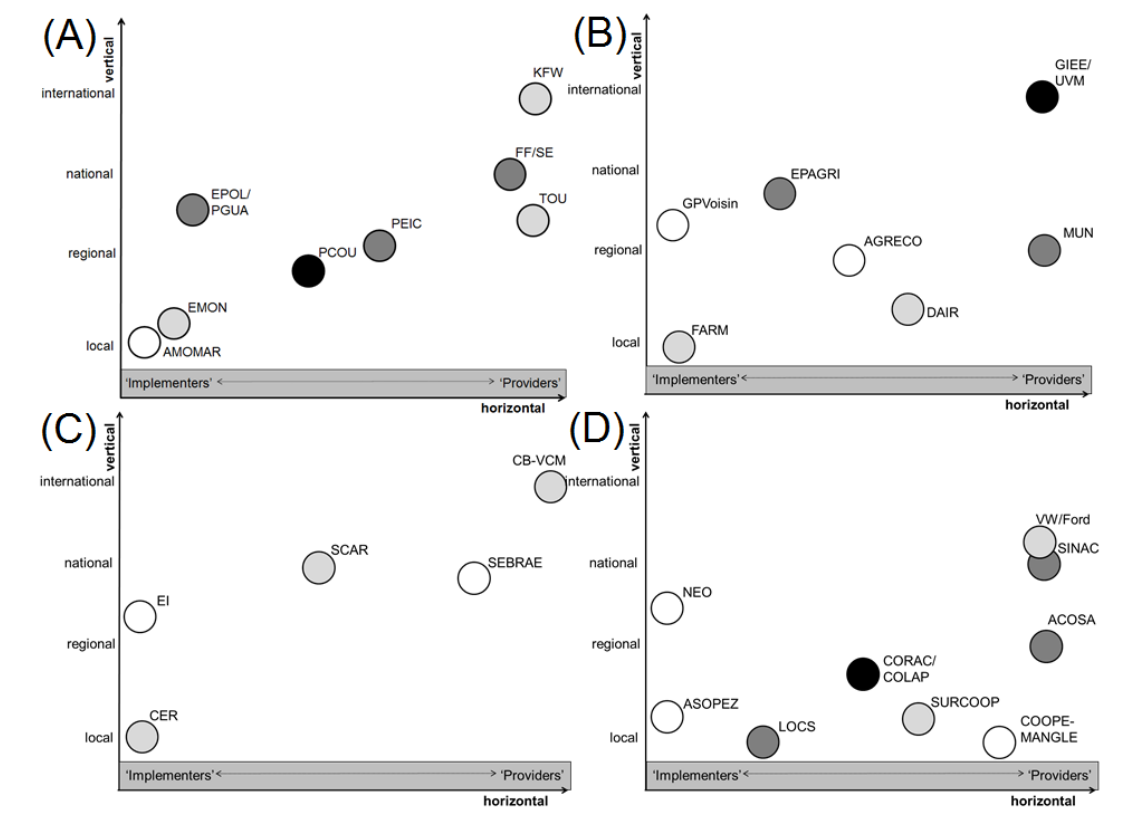
Fig. 3. Actors’ roles in community-based environmental management interactions. (A) Marujá, (B) Santa Catarina, (C) Tocantins, (D) Osa. White = civil society (nonprofit) actors, light gray = market (corporate or private) actors, dark gray = state (government or public) actors, and black = cross-sectoral actors (e.g., research institutes or governance actors engaged in more than one